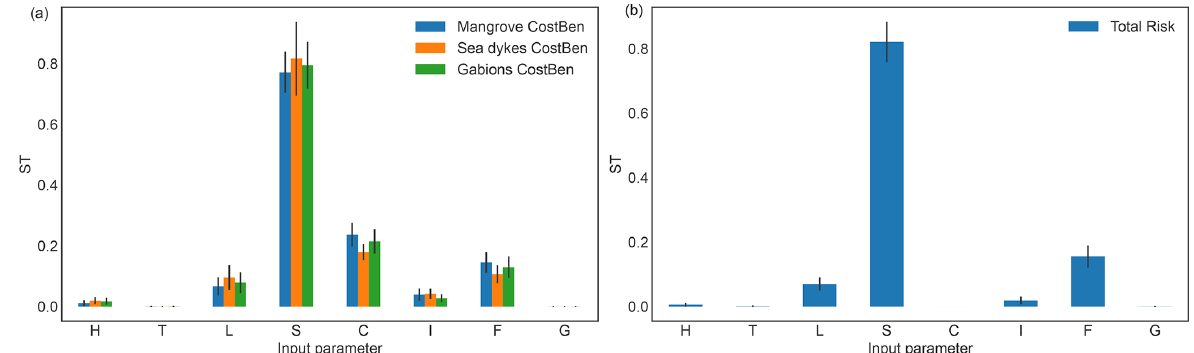
Figure 5. Total-order Sobol (cid:48) sensitivity indices (ST) for the uncertainty of (a) storm surge adaptation options benefits for mangroves, sea dykes, and gabions and of (b) the total risk without adaptation measures, for the time period 2020–2050 under the climate-change scenario RCP8.5. The input parameters (cf. Table 1) are H : hazard events bootstrapping, T : total population, L : population distribution, S : impact function intensity threshold shift, C : cost of adaptation options, I : hazard intensity change, F : hazard frequency change, and G : population growth. The vertical solid black bars indicate the 95th percentile confidence